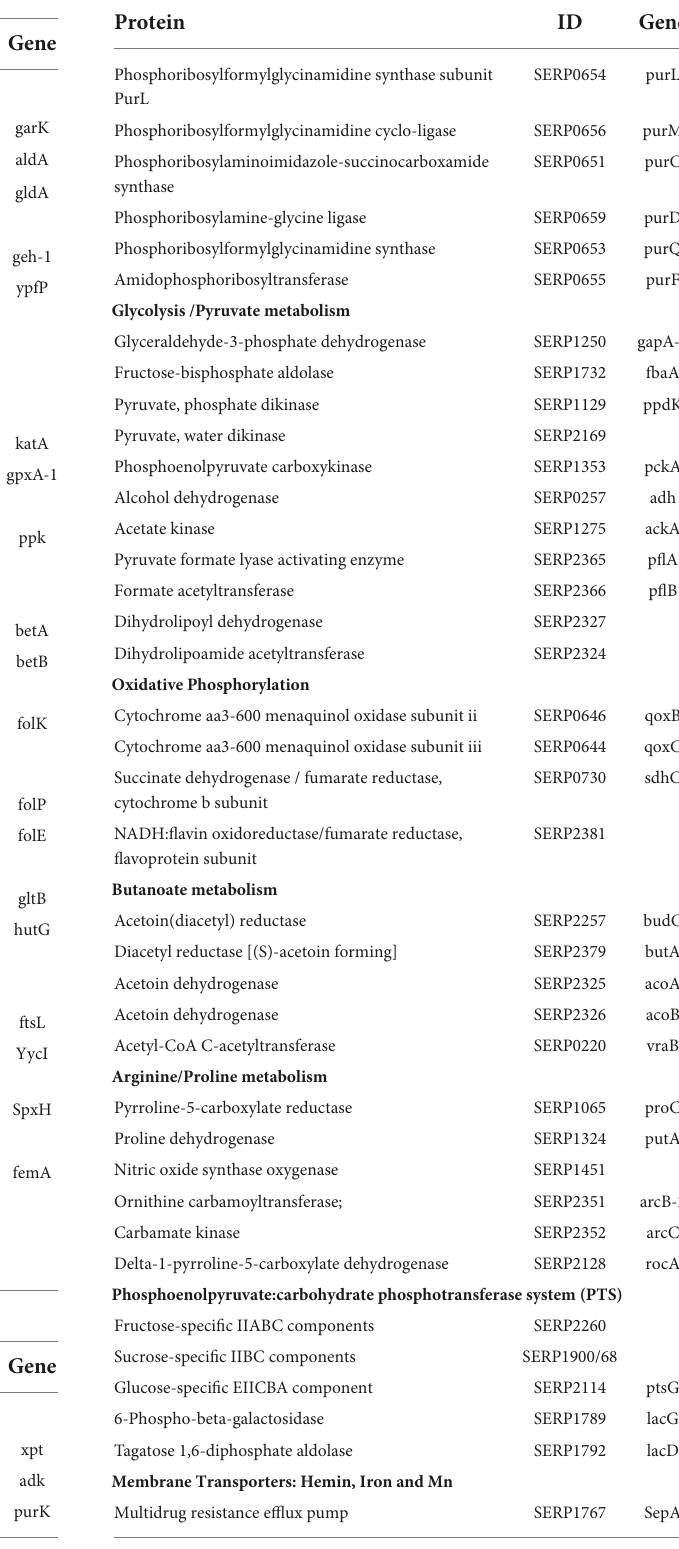
TABLE 2 Functional analysis of differentially abundant proteins between N55 and N77 conditions. Increased at pH